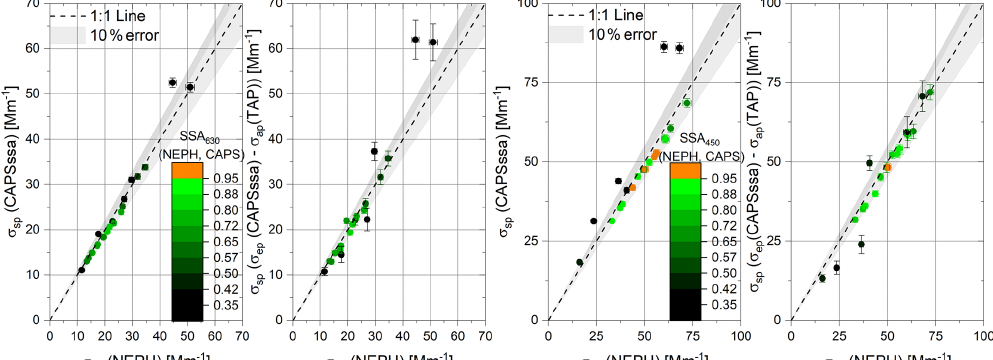
et al., 2005). The outliers in the CAPS vs. NEPH plots, espe- cially at 450 nm wavelength, are currently unexplained and are likely due to apparent stability issues for these